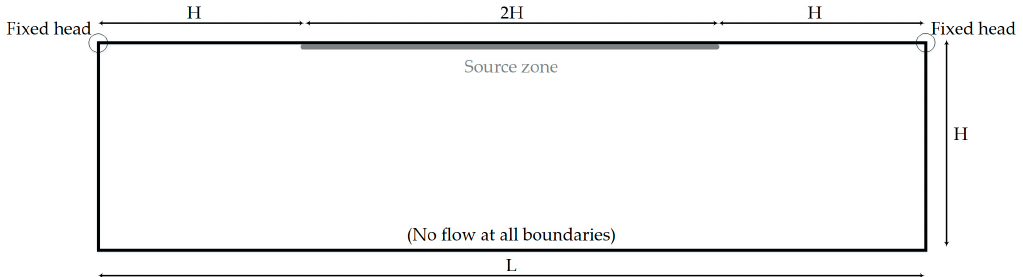
Figure 1. The fractured Elder problem domain and boundary conditions. All boundaries were impermeable to flow.